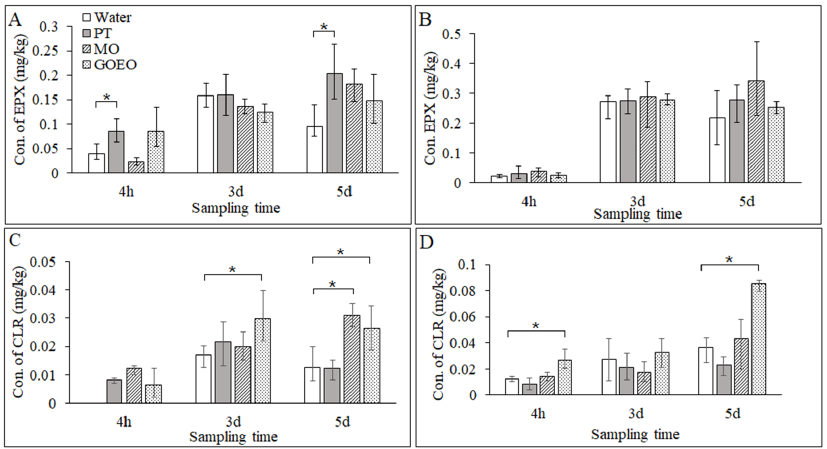
Figure 5. The concentrations of EPX and CLR in rice roots: ( A ) EPX at 125 mg/L, ( B ) EPX at 187 mg/L, ( C ) CLR at 66.7 mg/L, and ( D ) CLR at 100 mg/L. * p < 0.05.